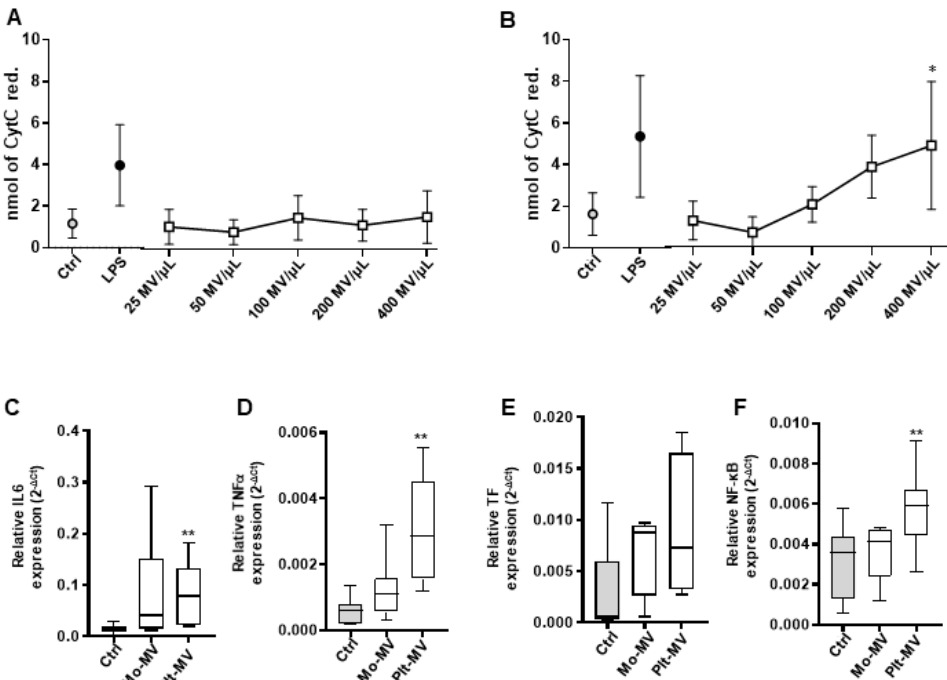
Figure 5. Effects of MVs released from monocytes and platelets isolated from STEMI patients on endothelial cells stress status. Superoxide anion production by hECV untreated (Ctrl), incubated overnight with LPS (as positive control), or incubated 30 min with the reported concentration of monocyte (Mo-) or platelet (Plt-)-derived MVs ( A , B , respectively). Data are expressed as nmoles of cytochrome C reduced/10 6 cells/30 min and are represented as mean ± SD of 5 independent experiments and analyzed by one-way ANOVA with Dunnett’s test for multiple comparison. * p < 0.05 vs. untreated cells (Ctrl). Gene expression of IL-6 ( C ), TNF α ( D ), TF ( E ), and NF-kB ( F ) in hECV stimulated 6 h with Mo- or Plt-MVs from STEMI patients. Data are represented in box and whisker plot (min to max) and analyzed by one-way ANOVA with Dunnett’s test for multiple comparison (TNF α , NF- κ B) or Kruskall–Wallis with Dunn’s test for multiple comparison (IL-6). ** p < 0.01 vs. untreated cells (Ctrl).